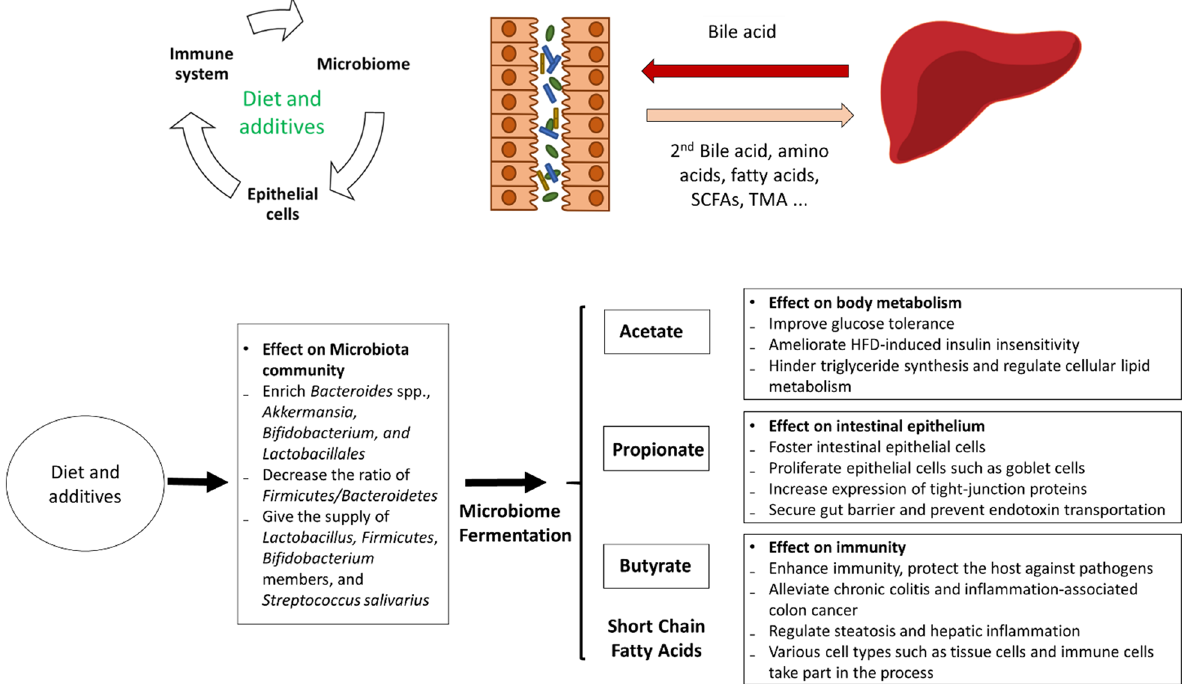
Fig. 1 Beneficial effect of SCFAs on Gut–liver axis. There is a close relationship between the liver and the gut. Humans consume food that is digested and metabolized by microbiota in the gut to produce essential metabolites, such as trimethylamine (TMA), amino acids, and fatty acids, which are transported to the liver via portal veins. Since different microbiota results in distinct products of digestion that will be transported to the liver, healthy gut microbiota is essential for a healthy liver. Diet modification and additives (prebiotics and probiotics) consumption are promising approaches to have a healthy microbiota community. SCFAs are products of the beneficial bacterial community which have various benefits toward the host consisting of improving overall metabolism, strengthening intestinal epithelium, and regulating immune